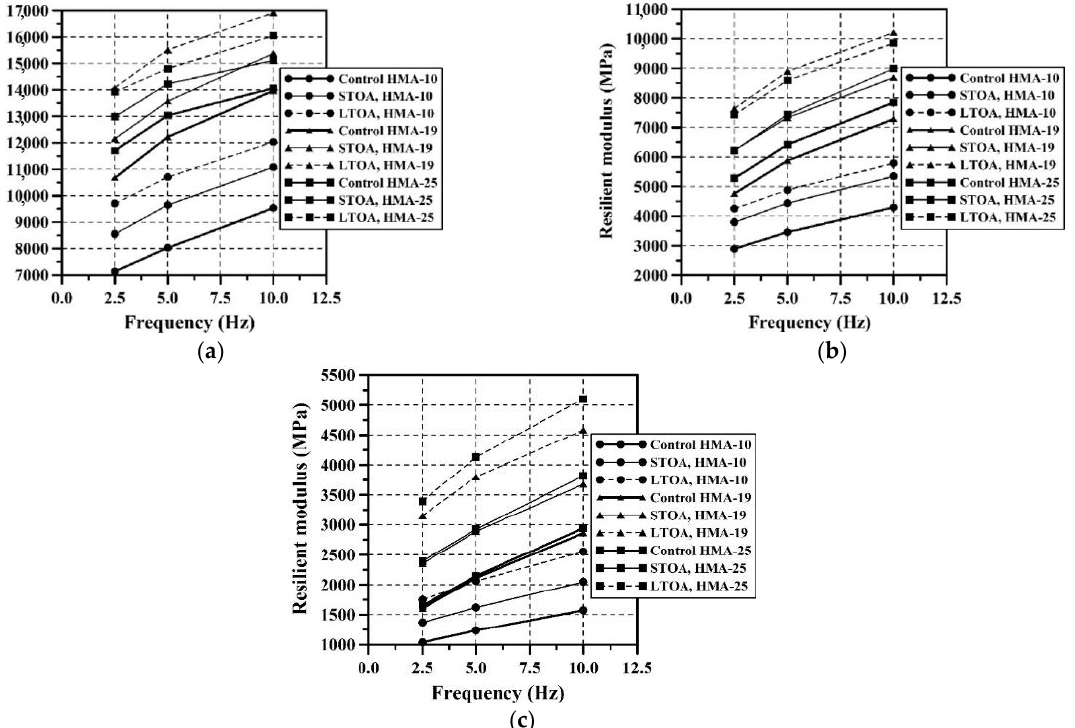
Figure 4. Resilient modulus at ( a ) 10 °C, ( b ) 20 °C, and ( c ) 30 °C.